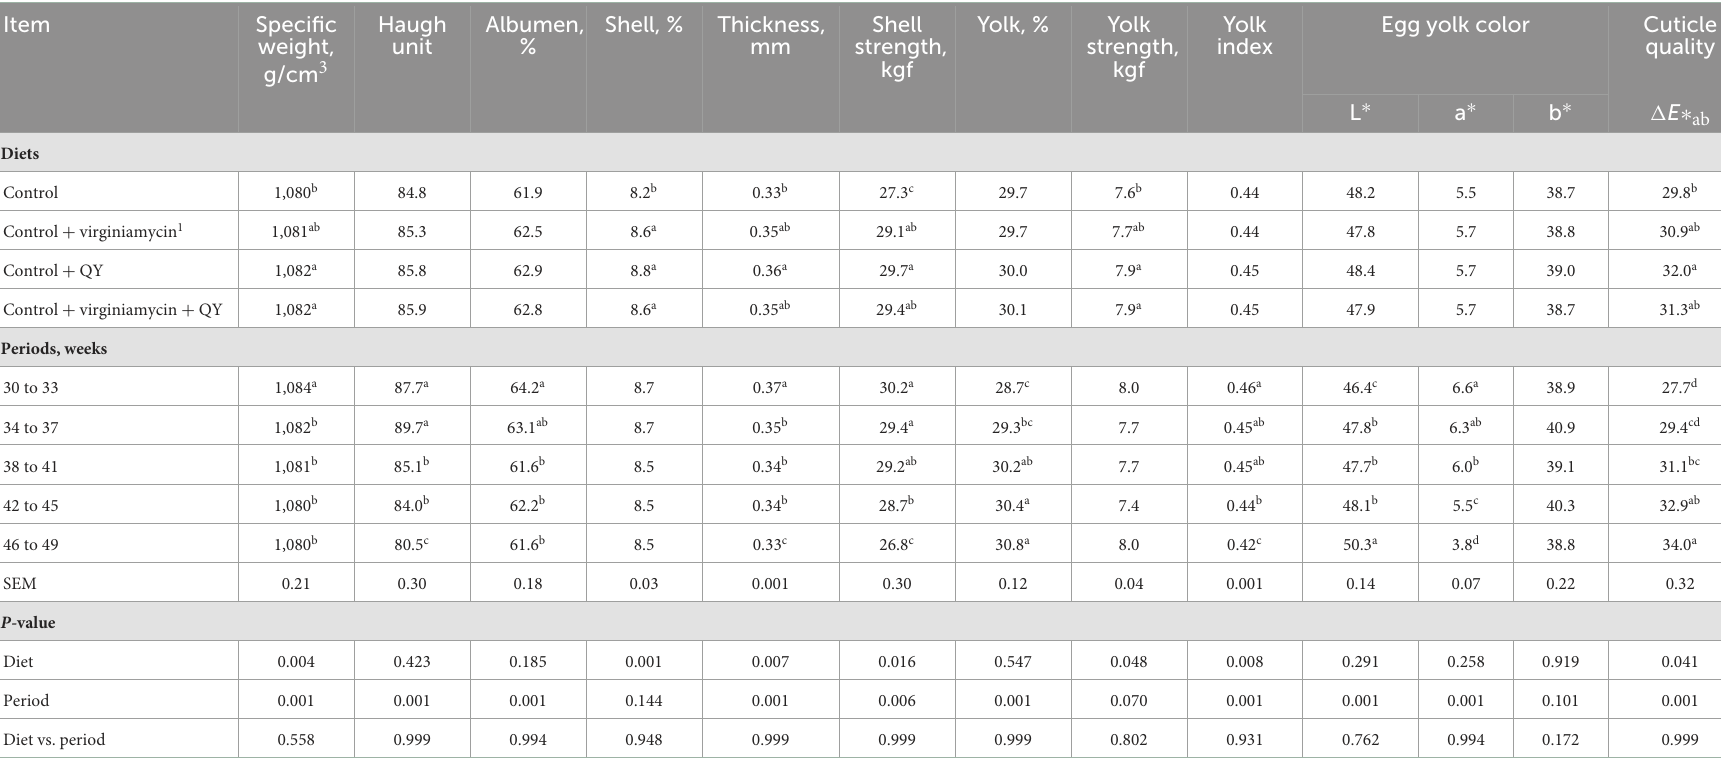
TABLE 3 Quality of egg, eggshell, and cuticle ( 1 E ∗ ab ) of laying breeders fed diets supplemented with an additive from Quillaja saponaria and Yucca schidigera (QY) from 30 and 49 weeks of